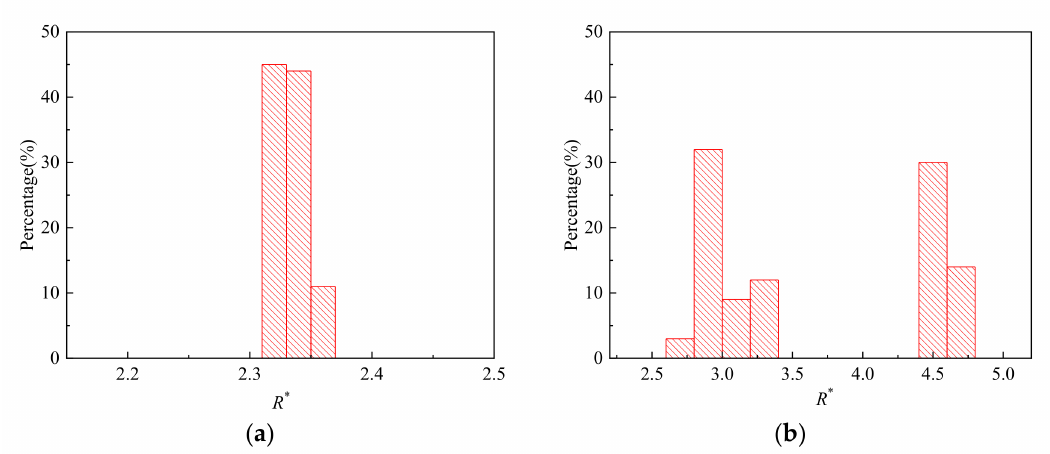
Figure 9. Size distribution of droplets: ( a ) q d = 75 mL / h, We = 0.13, Bo = 0.027; ( b ) q d = 255 mL / h, We = 0.22, Bo =